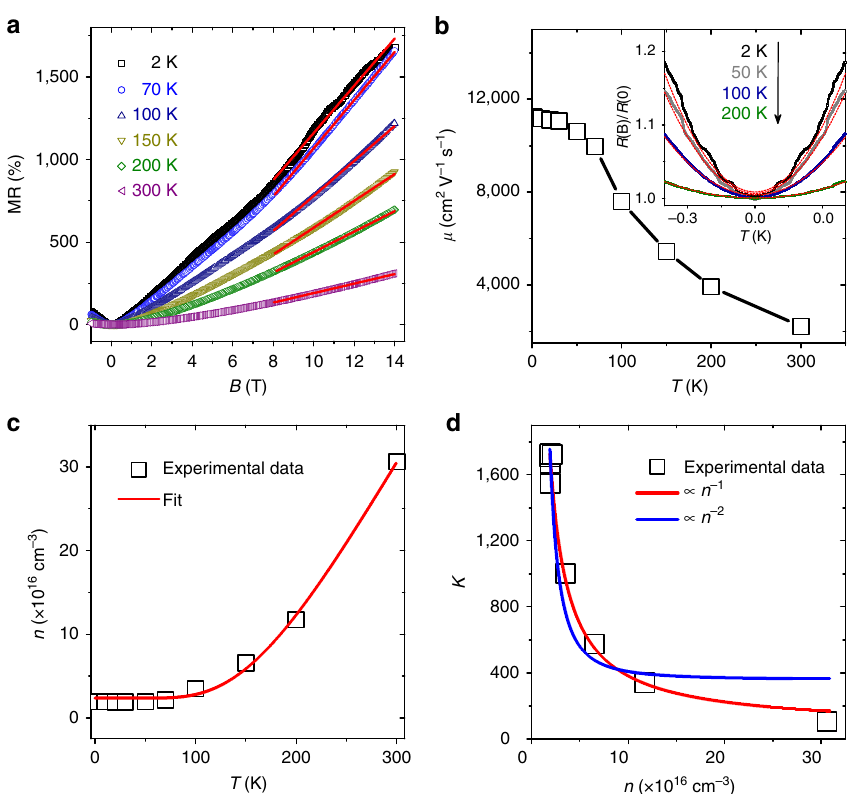
Figure 3 | Linear MR in B perpendicular to E . ( a ) The MR measured at different T indicated. ( b ) The T dependence of the carrier mobility, which is calculated using Kohler’s rule or equation (1). Inset: the MR at small magnetic fields and the parabola fittings (solid lines) at different T indicated. ( c ) The carrier density as a function of T . The solid red curve is the fitting using Arrhenius’s law. ( d ) The slope k of the linear MR at high B (from 8 to 14T, obtained in a , see solid curves) as a function of carrier density, n . The solid red and blue curves are the fittings using n (cid:3) 1 and n (cid:3) 2 , respectively. The corresponding temperature for each data point is also